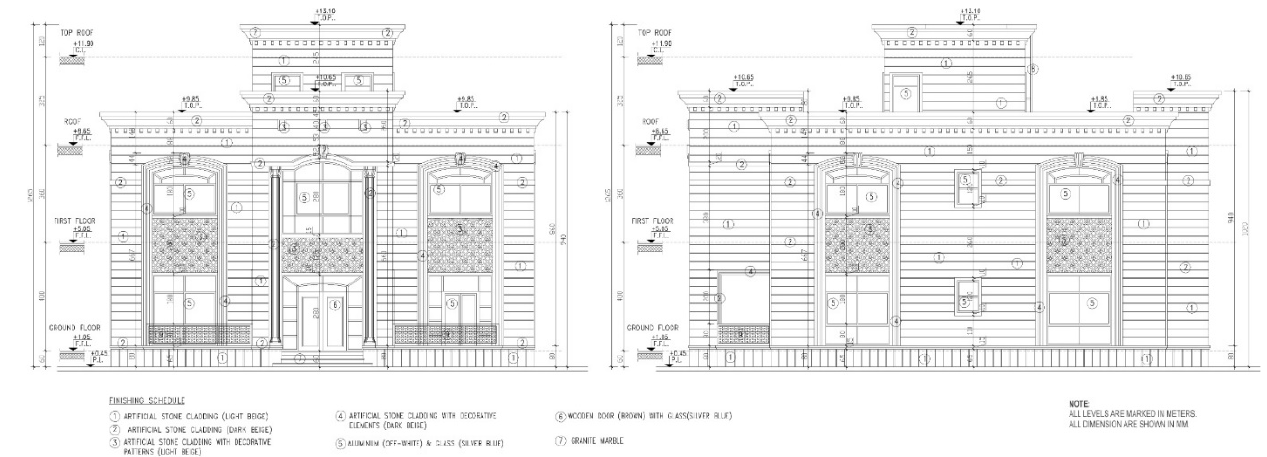
Figure 2. Front and side elevation of case study villa.